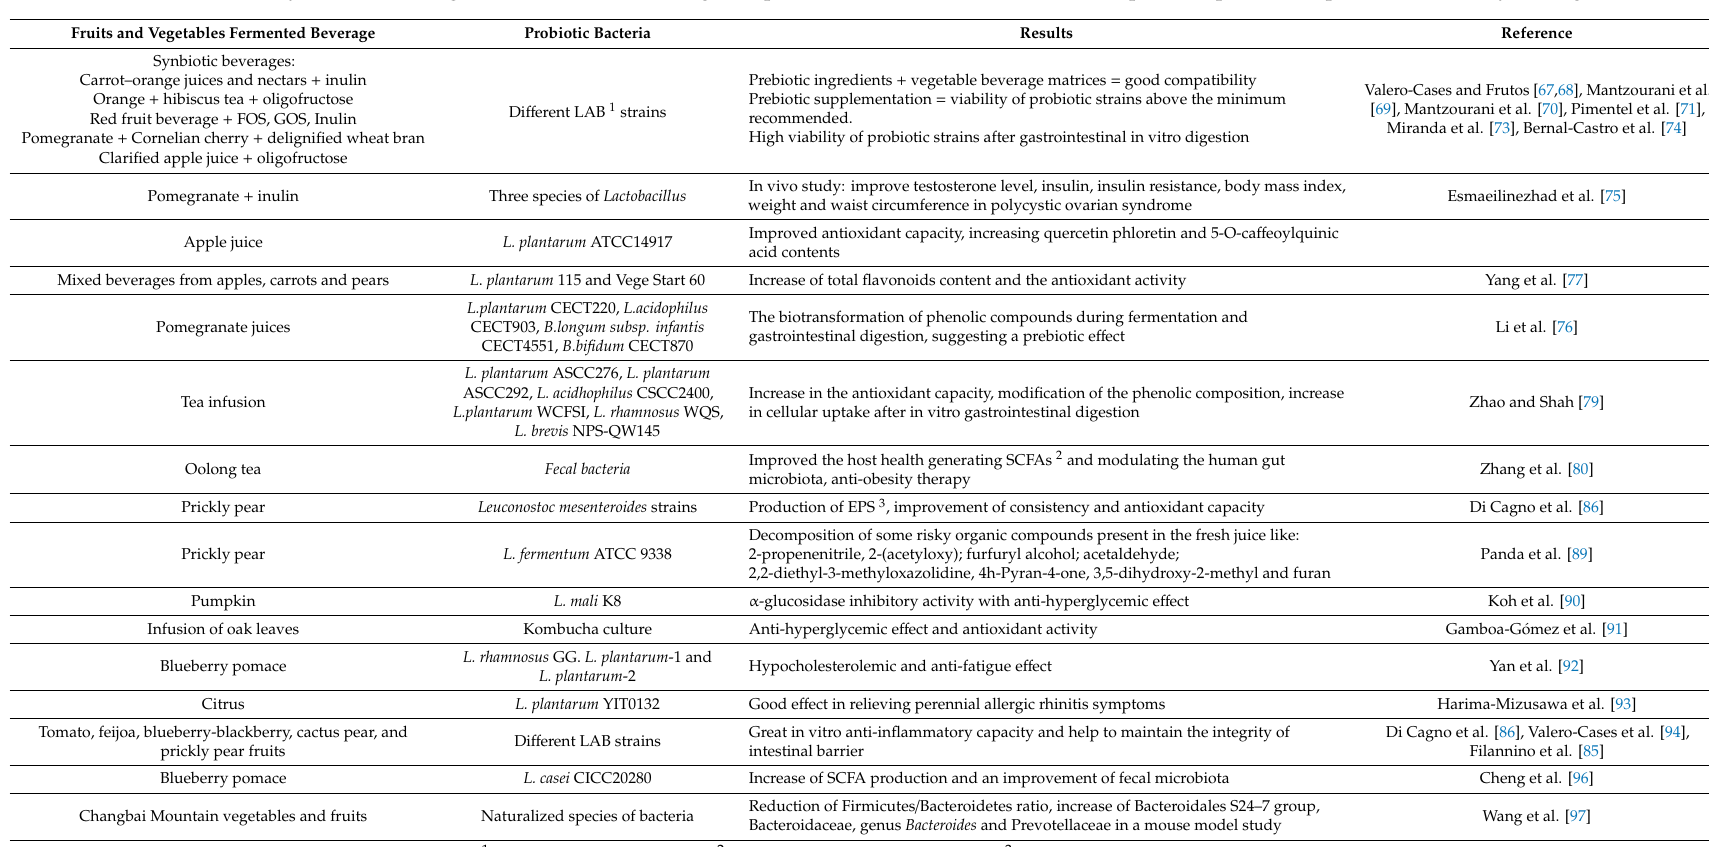
Table 4. Summary of fruit and vegetable fermented beverages as potential carriers form bioactive compounds, probiotics, prebiotics delivery to de gut. Fruits and Vegetables Fermented